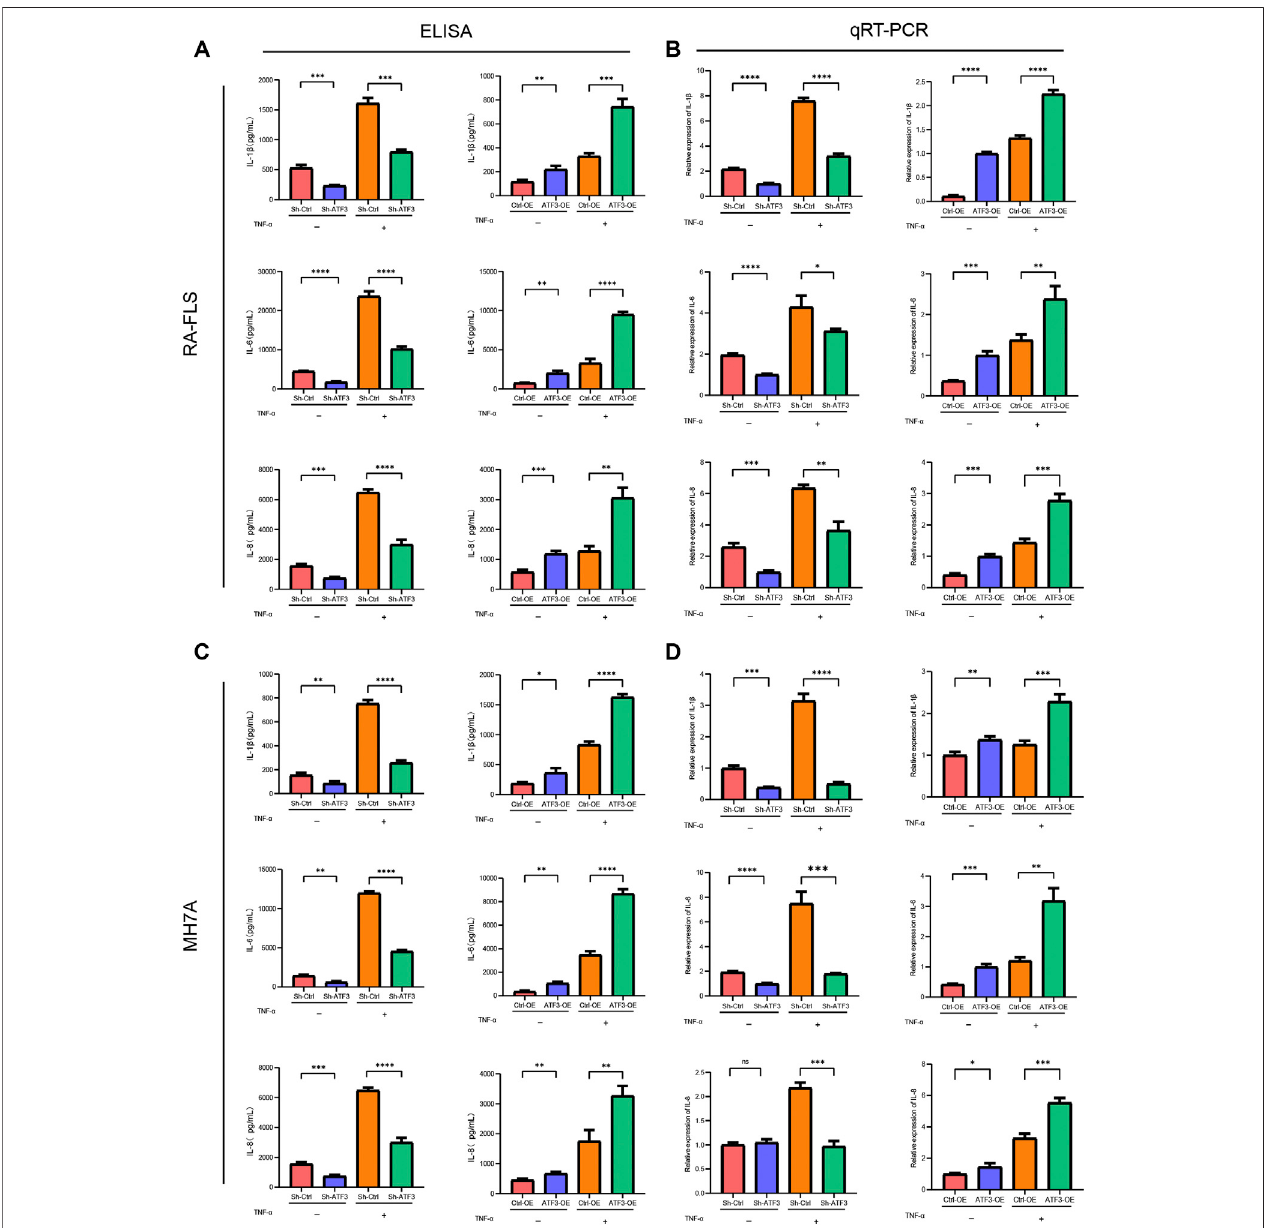
FIGURE 10 | ATF3 facilitating pro-in fl ammatory cytokine secretion in rheumatoid arthritis fi broblast-like synoviocyte (RA-FLS) and MH7A. (A and C) ELISA assays showed that IL-1 β , IL-6, and IL-8 in the Sh-ATF3 group were lower than those in the Sh-Ctrl group with or without TNF- α stimulation, which in the ATF3-OE group were higherthanthoseintheCtrl-OEgroup(mean ± SD,n (cid:1) 3). (BandD) Similarly,qRT-PCRassaysrevealedthatIL-1 β ,IL-6,andIL-8intheSh-ATF3groupwerelowerthan thoseintheSh-CtrlgroupwithorwithoutTNF- α stimulation,whichintheATF3-OEgroupwerehigherthanthoseintheCtrl-OEgroup(mean ± SD,n (cid:1) 3).* p < 0.05, ** p < 0.01, *** p < 0.001, **** p <